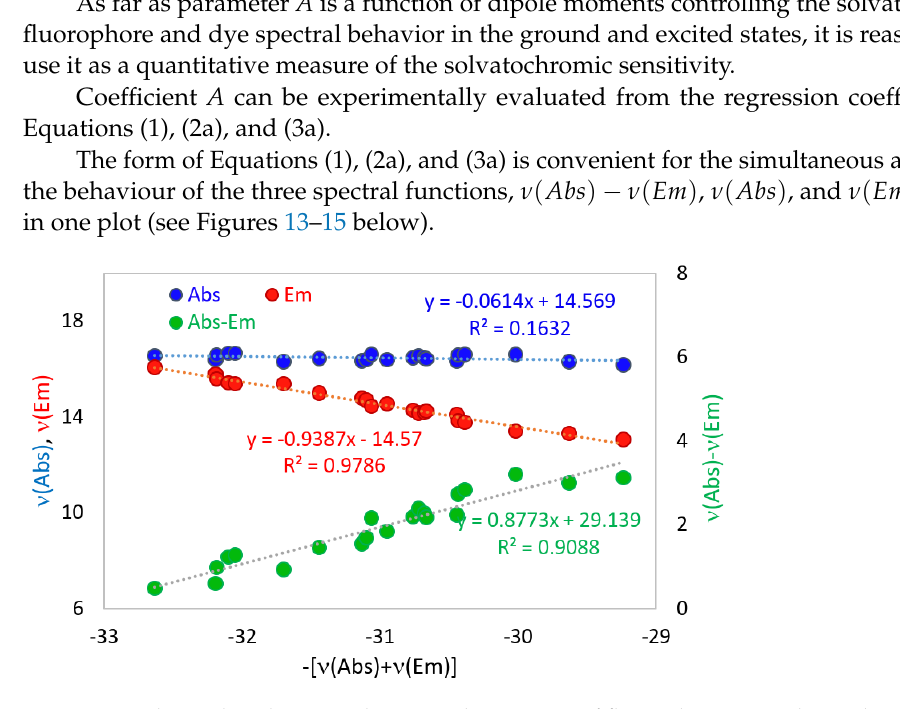
Figure 13. Relationships between the spectral properties of fluorophore 2010 Filarowski – 1 in a series of solvents according to Equations (1) – (3): A = 0.877, C = − 0.061, E = − 0.939.